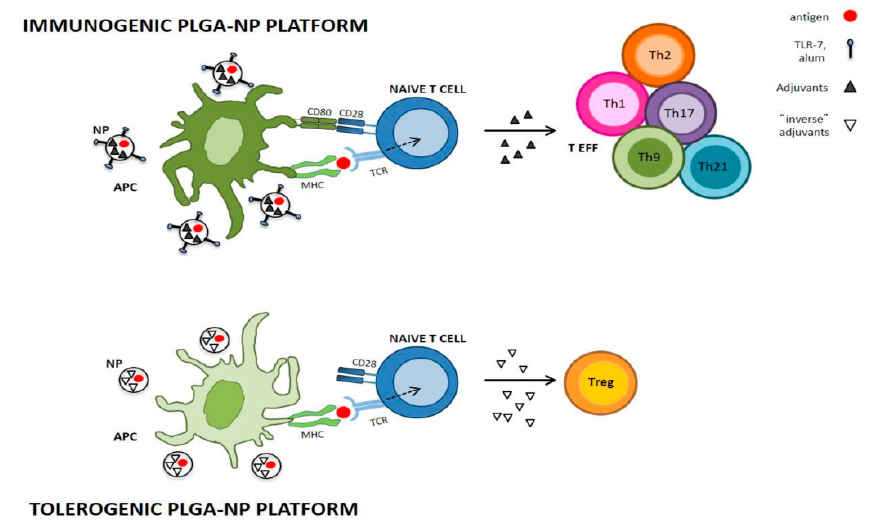
Figure 3. Immunogenic and tolerogenic poly(lactic- co -glycolic acid) (PLGA) NP (nanoparticle) Figure3. Immunogenicandtolerogenicpoly(lactic- co receptor 7 (TLR-7) agonists, capable of activating APCs (antigen-presenting cells) and promoting